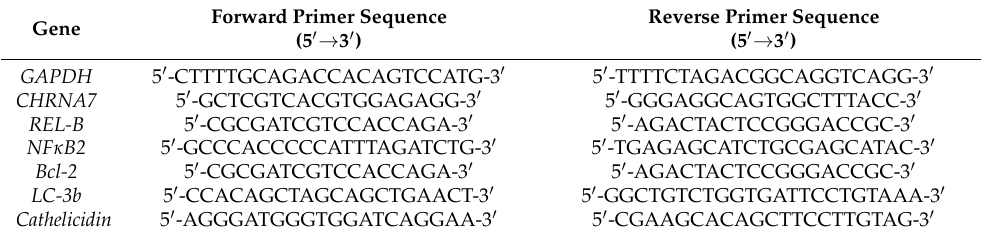
Table 1. RT-PCR primer sequences for tested